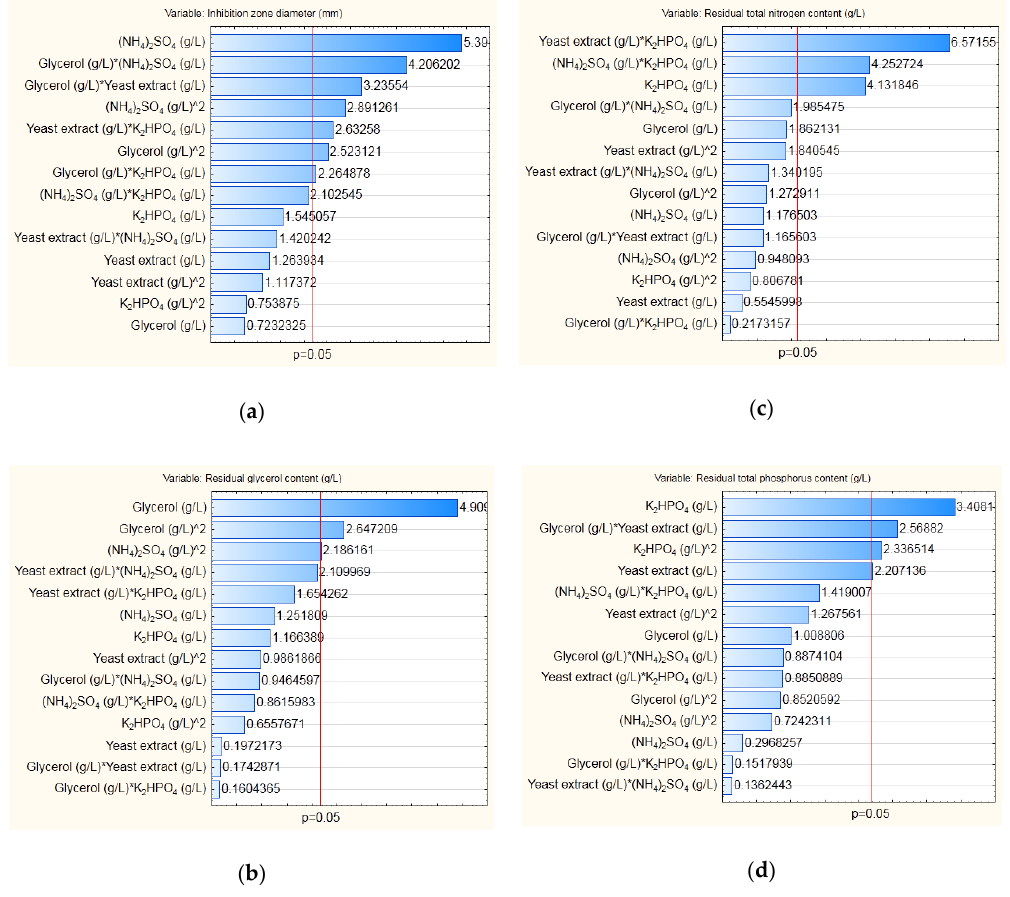
Figure 3. Pareto charts—coefficients of regression models for the selected dependent variables during modeling of medium composition for cultivation of B. velezensis IP22: ( a ) inhibition zone diameter, ( b ) residual glycerol content, ( c ) residual total nitrogen content, ( d ) residual total phosphorus content. The red line in the charts represents a limit of statistical significance ( p -value equal to 0.05) at the confidence level of 95%.